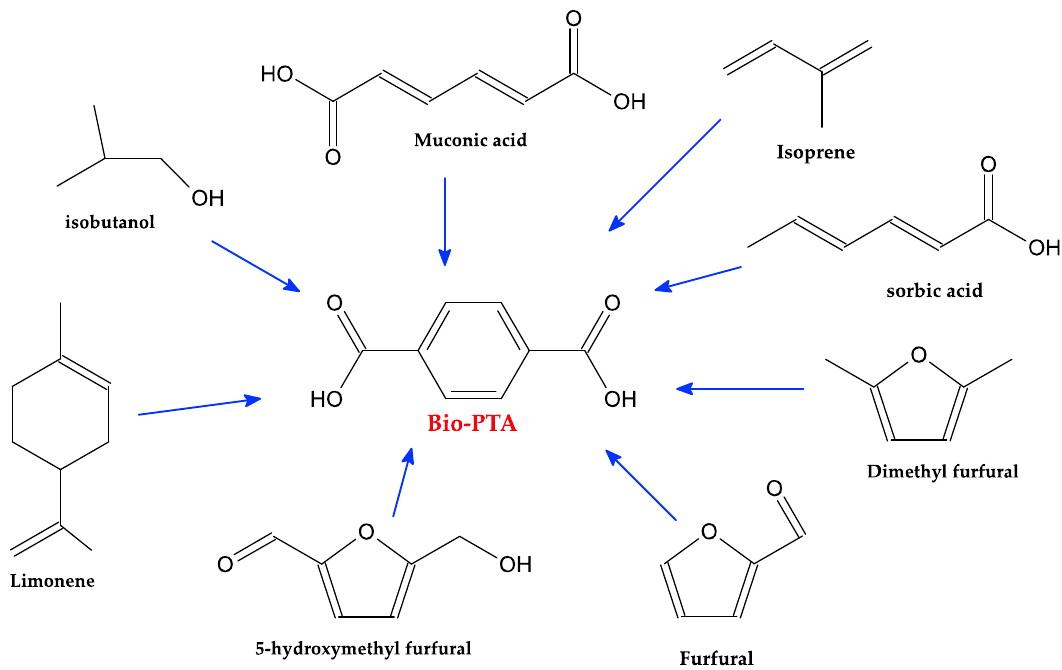
Figure 10. Schematic representation of the methods used to achieve bio-TA: ( a ) from iso-buthanol; ( b ) from muconic acid; ( c ) from limonene; and ( d ) from furfural.